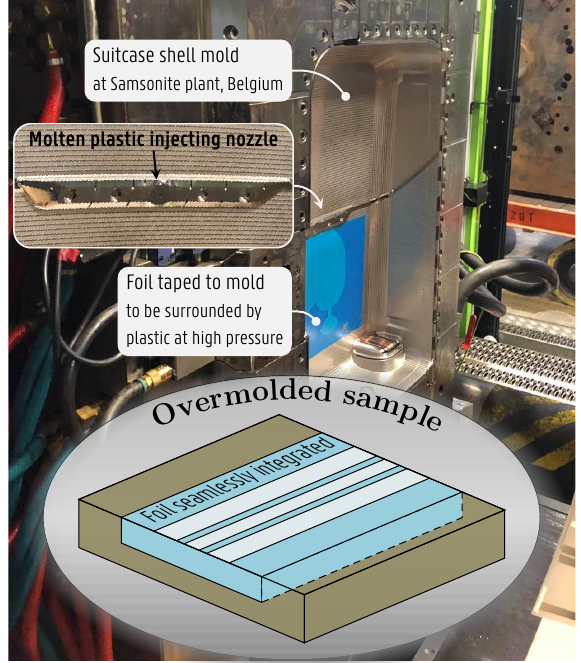
Figure 2. Illustration of the overmolding process. The foil carrying the antenna is taped to the suitcase shell mold, where molten plastic is injected at high pressure resulting in the foil being seamlessly integrated into the plastic